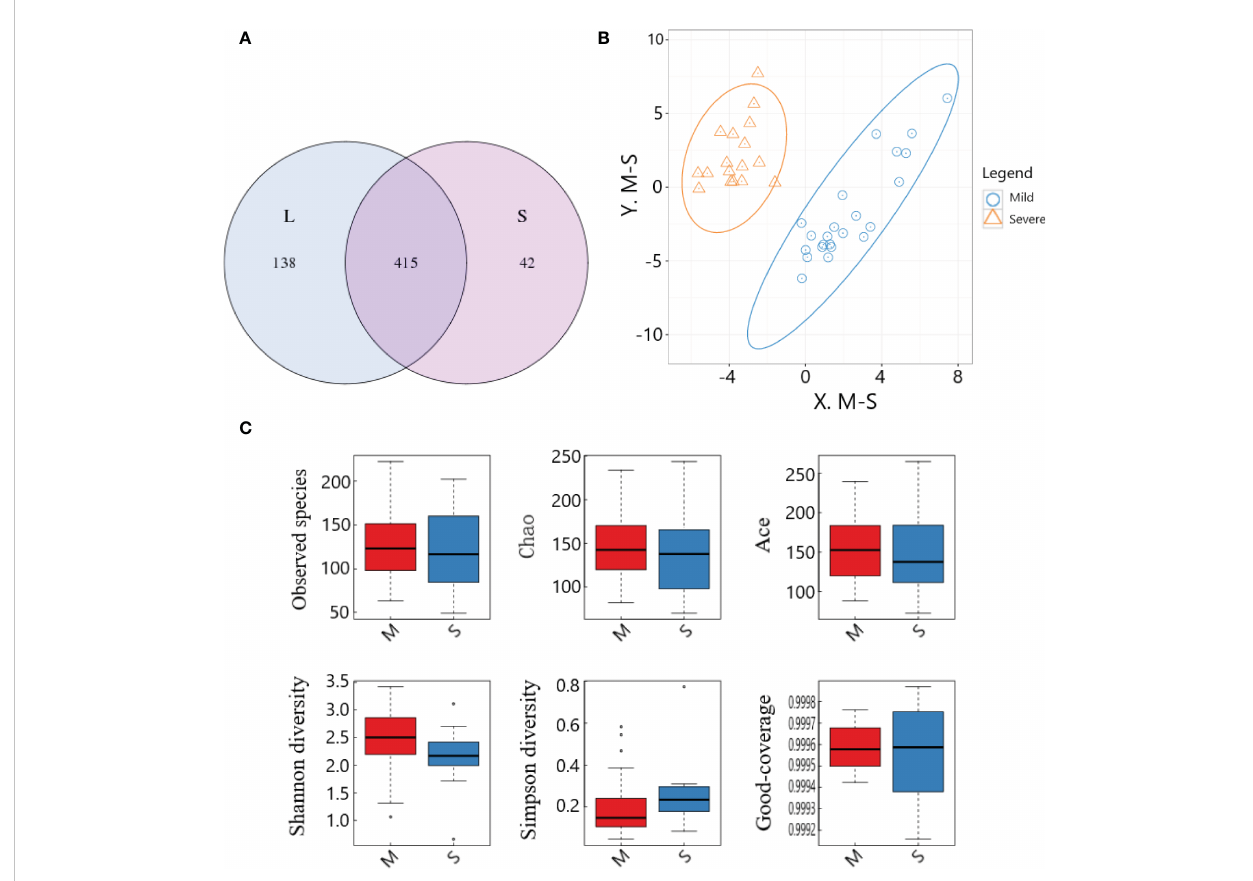
FIGURE 4 OTU cluster analysis and species diversity analysis of samples between the two groups. (A) OTU Venn diagram; (B) PLS-DA analysis; (C) Comparison of a -diversity.